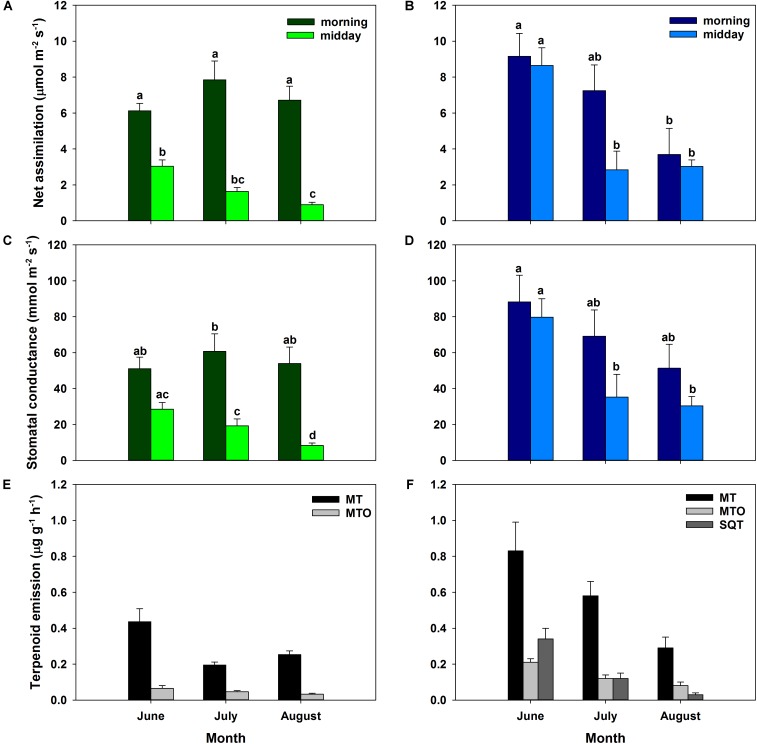
Assimilation rates and stomatal conductance for sun leaves for Q. suber (left, n = 9, A,C) and C. ladanifer (right, n = 7, B,D) with standard error for June, July, and August field campaigns. Letters indicate statistical differences (RMANOVA) of assimilation rates and stomatal conductance between sampling periods at a significance level of p < 0.05 for each species separately. Average measured terpenoid emissions of Q. suber (left, n = 6 for June, n = 8 for July and August, E) and C. ladanifer (right, n = 3 for June, n = 4 for July and August, F) with standard error. Emissions are grouped into monoterpenes (MT), oxygenated monoterpenes (MTO), and sesquiterpenes (SQT).